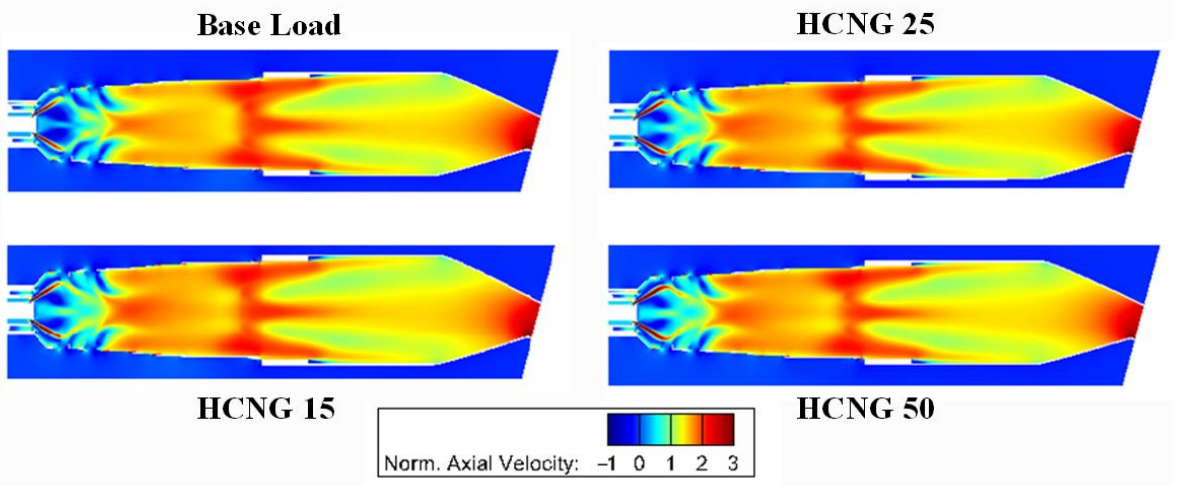
Figure 12. Axial velocity contours in slice 2.